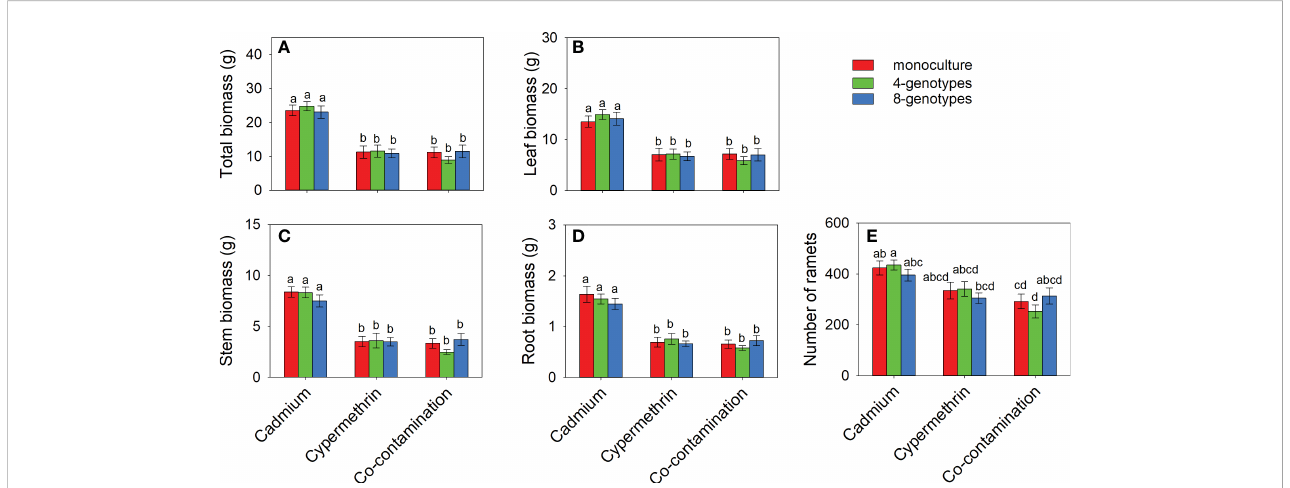
FIGURE 1 Total biomass (A) , leaf biomass (B) , stem biomass (C) , root biomass (D) and number of ramets (E) of Hydrocotyle vulgaris population consisting of different number of genotypes under different pollutant treatments. Mean values ( ± 1 SE) are presented. Letters (a-d) above the bars indicate signi fi cant differences ( P < 0.05) among each panel. See Table 1A for ANOVA